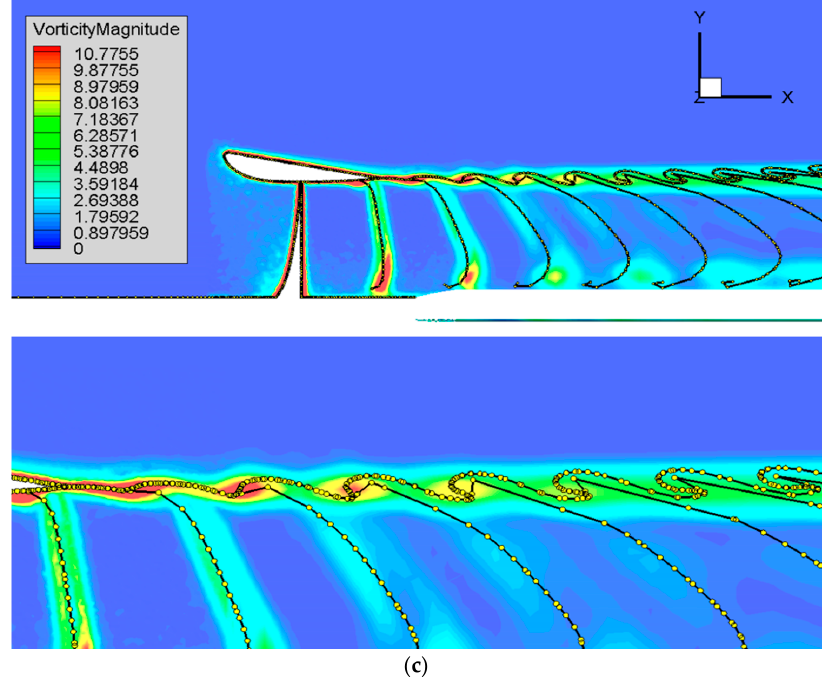
Figure 13. Comparison of the contour plots of vorticity in the duct and blade wake predicted from RANS, and the trailing wake shapes on the duct and blade predicted by the present method (shown with a black solid line) for advance ratios of 0.3 ( a ), 0.4 ( b ), and 0.5 ( c ). All shown quantities and wake shapes correspond to the intersection of a vertical plane through the axis of the ducted propeller.